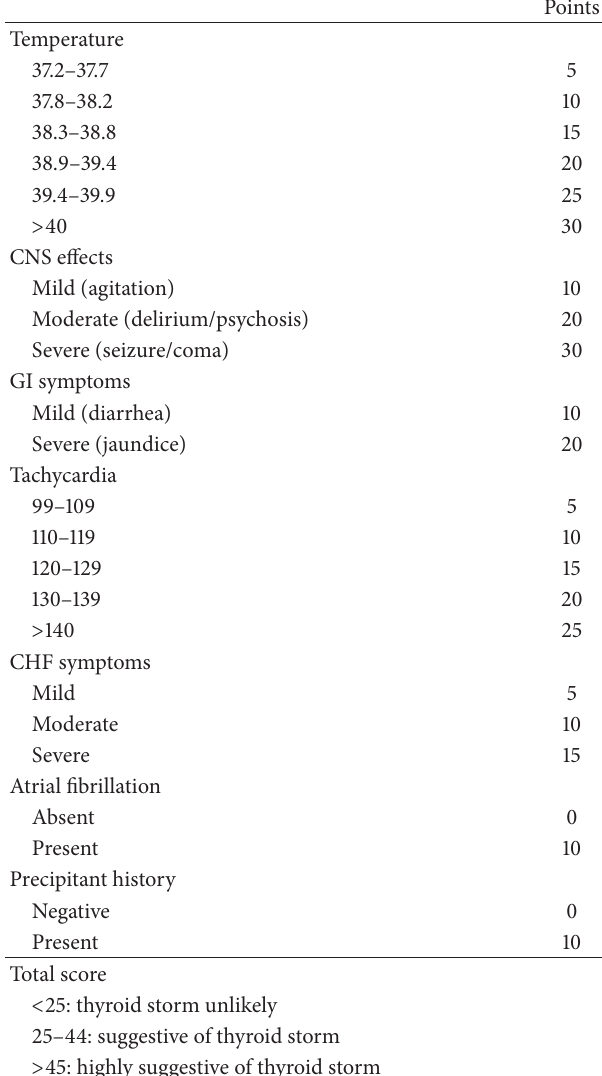
Table 1: Burch-Wartofsky thyroid storm scoring